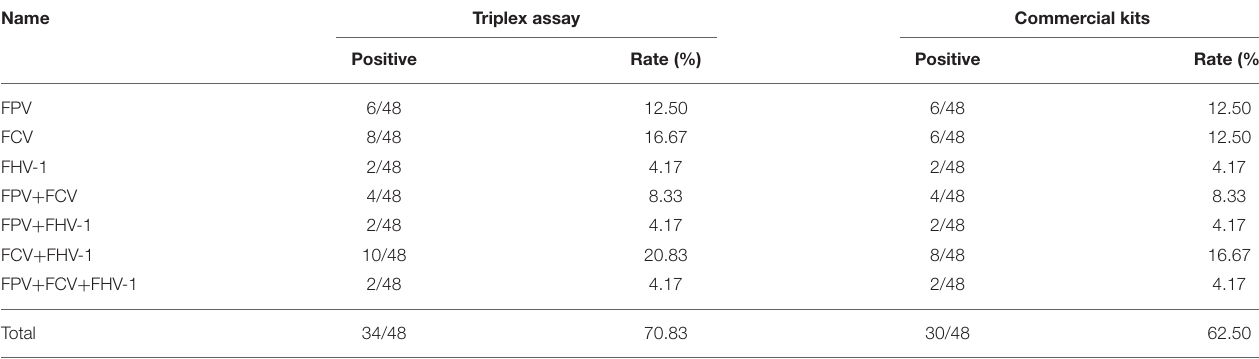
TABLE 5 | Clinical samples detected by triplex assay and commercial